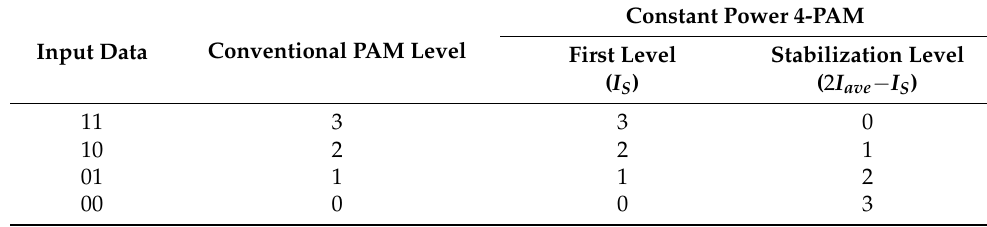
Table 1. Proposed CP 4-PAM